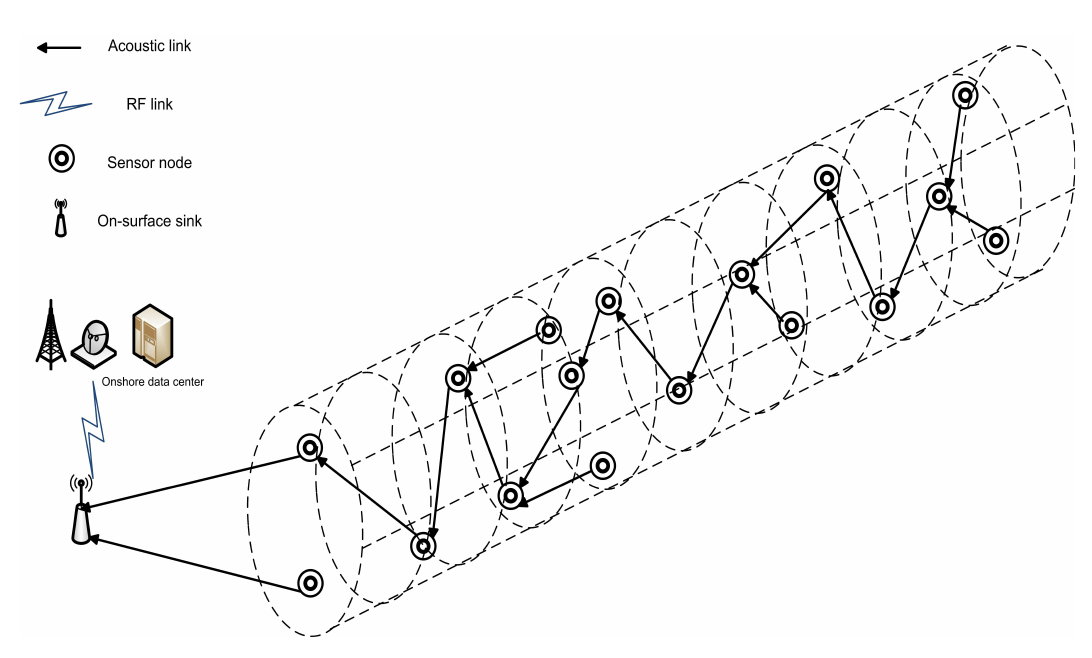
Figure 7. Single-chain based